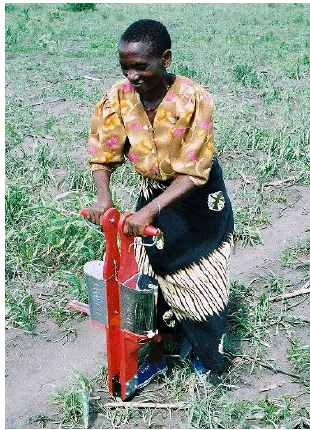
Figure 6. A manually operated jab ‐ planter with hoppers for seed and fertilizer.